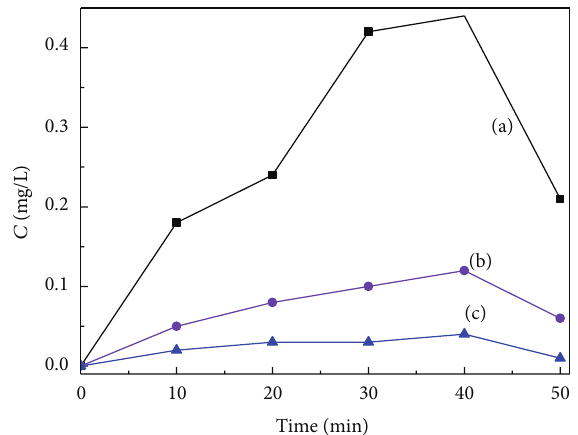
Figure 7: Variation of (a) phenol; (b) 4-CP; (c) 2-CP concentration during the photo